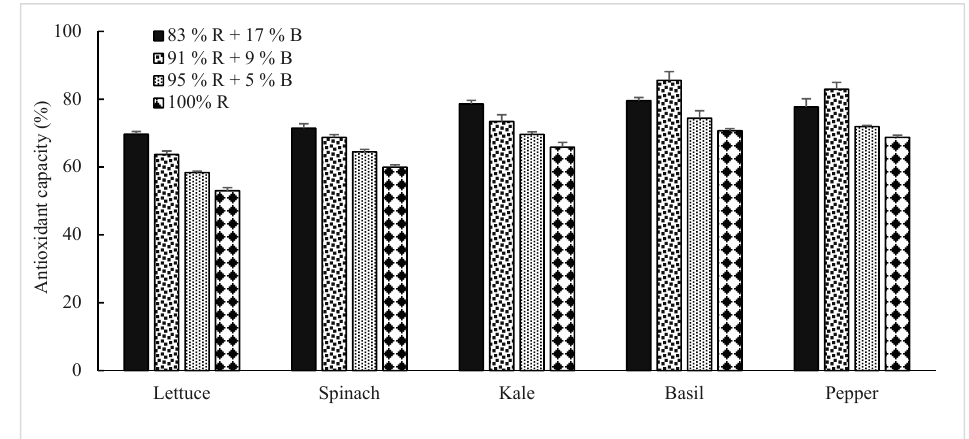
Figure 4. The effect of different percentages of red (R) and blue (B) LEDs on DPPH radical scavenging activity in vegetable crops. Bars represent the standard deviation (n = 6) ( p < 0.05).